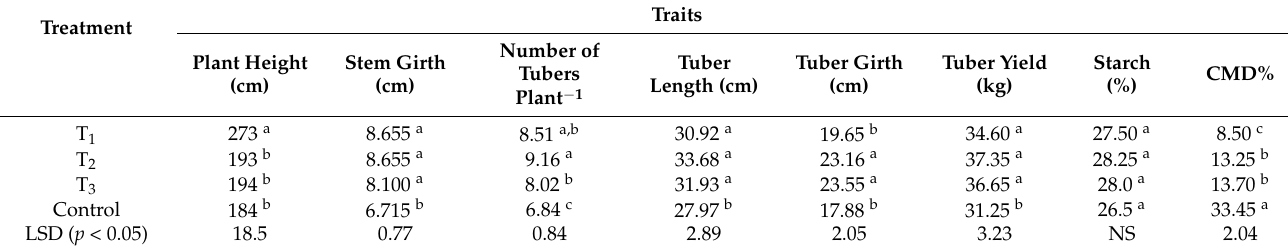
Table 3. Effect of combined nutrient/biocontrol agent mixture foliar spray on plant height (cm), stem girth (cm), number of tubers plant − 1 , tuber length (cm), tuber girth (cm), tuber yield (kg), starch (%), and cassava mosaic disease incidence (CMD-%) of cassava. The data presented are mean of two experiments ( n = 10). Means followed by the same letter are not statistically significant at p < 0.05.